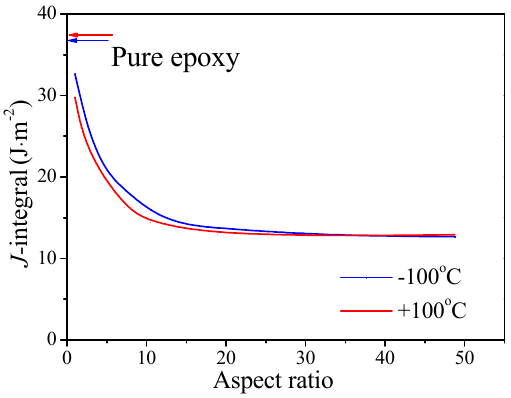
Figure 10. Effect of rod-shape fillers on interfacial J i values subjected to thermal shock.